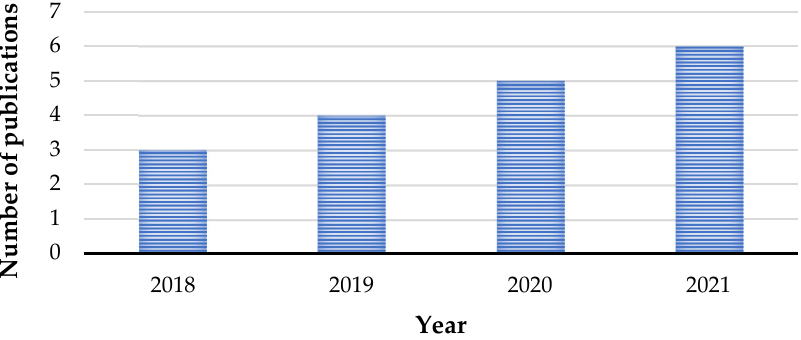
Figure 3. Number of SDT publications in the last four years. Nine different modelling methods have been used in the reviewed papers, as well as the combinations of these methods, where mathematical modelling and FEM are the two most commonly used, as shown in Figure 5. Both were used in 22% of the reviewed publications, while classical data-driven modelling methods and its modern sibling, ANNs, were each used in 15% of the cases considered. Grey box modelling, as a hybrid of the physical and data-based approach, has been used in 7% of the cases, as well as CMV, while the rest of the methods have been used in single